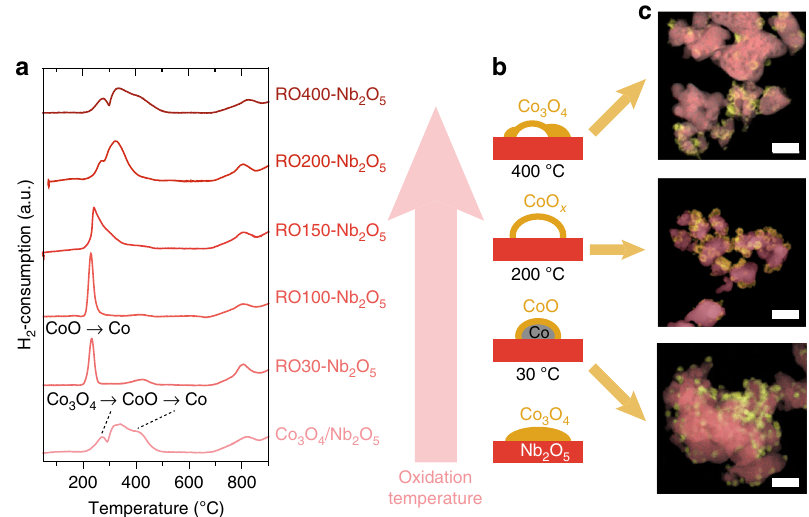
Fig. 2 The effect of the oxidation temperature on the structure of Co/Nb 2 O 5 . a Temperature-programmed reduction pro fi les, b schematic illustration, and c STEM-EDX images of Co/Nb 2 O 5 after reduction and oxidation at various temperatures (30 – 400 °C). Co is depicted in yellow, Nb in red. The scale bar corresponds to 100 nm